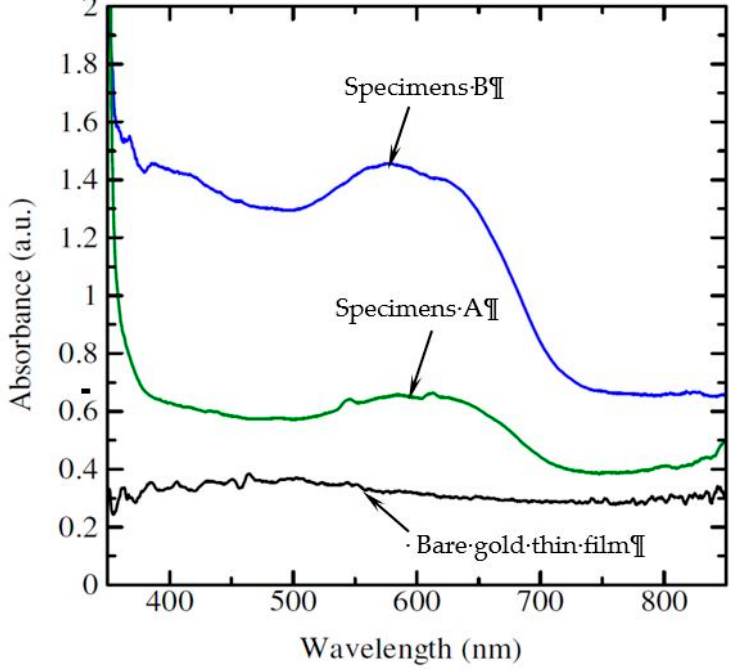
Figure 9. The absorbance spectrum .